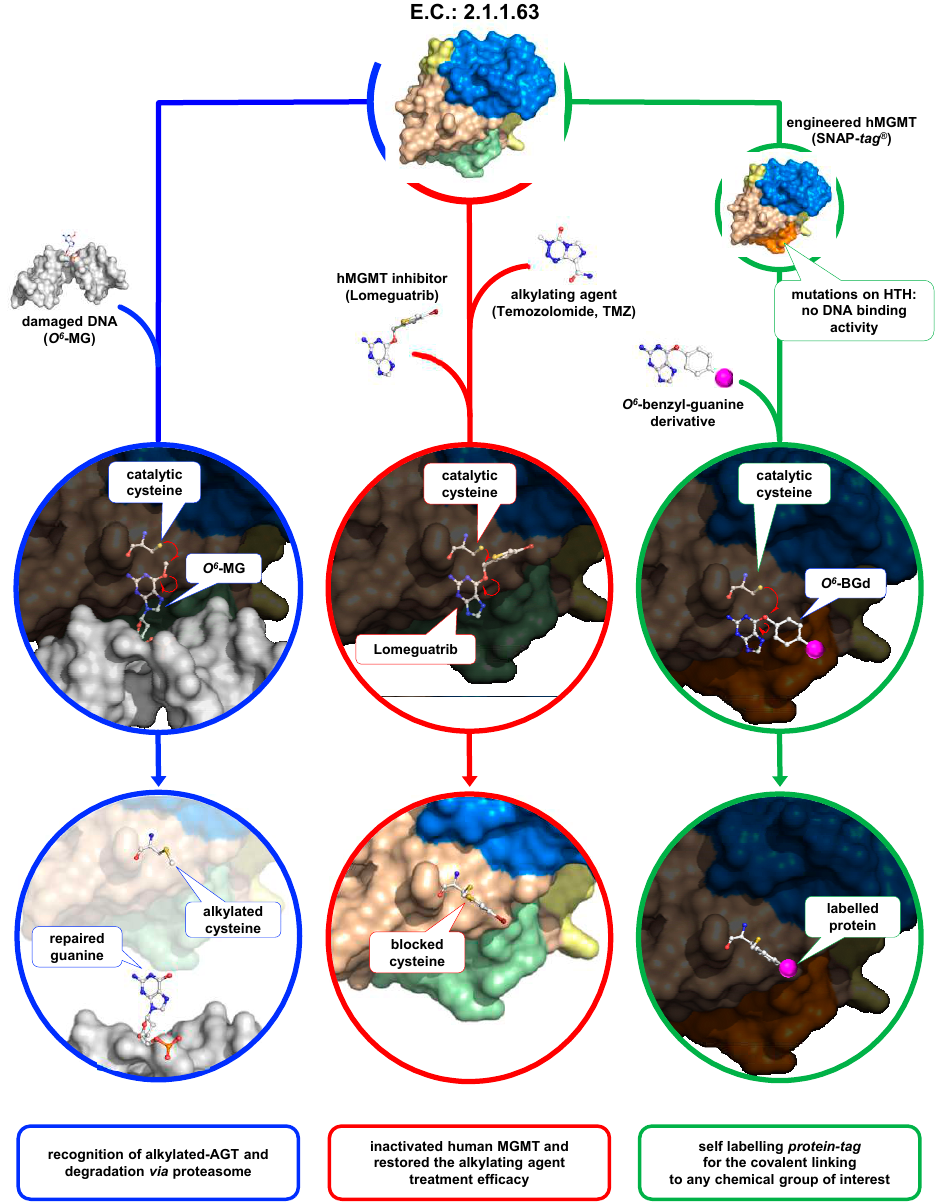
Figure 1. The O 6 -alkyl-guanine-DNA-alkyl-transferase (AGT)s’ world. AGTs are small enzymes composed by a N-terminal domain (in sky blue), a C-terminal domain (in light brown) connected by a loop (in yellow). In the C-terminal domain, a helix-turn-helix motif (in light green, or in orange in the SNAP- tag ) is responsible of the DNA-binding activity. The peculiar irreversible reaction mechanism of these enzymes plays a pivotal role in the physiological DNA repair (blue path), and it has important repercussions in cancer cell treatment (red path) and biotechnological applications (green path). Atoms are coloured by the CPK colour